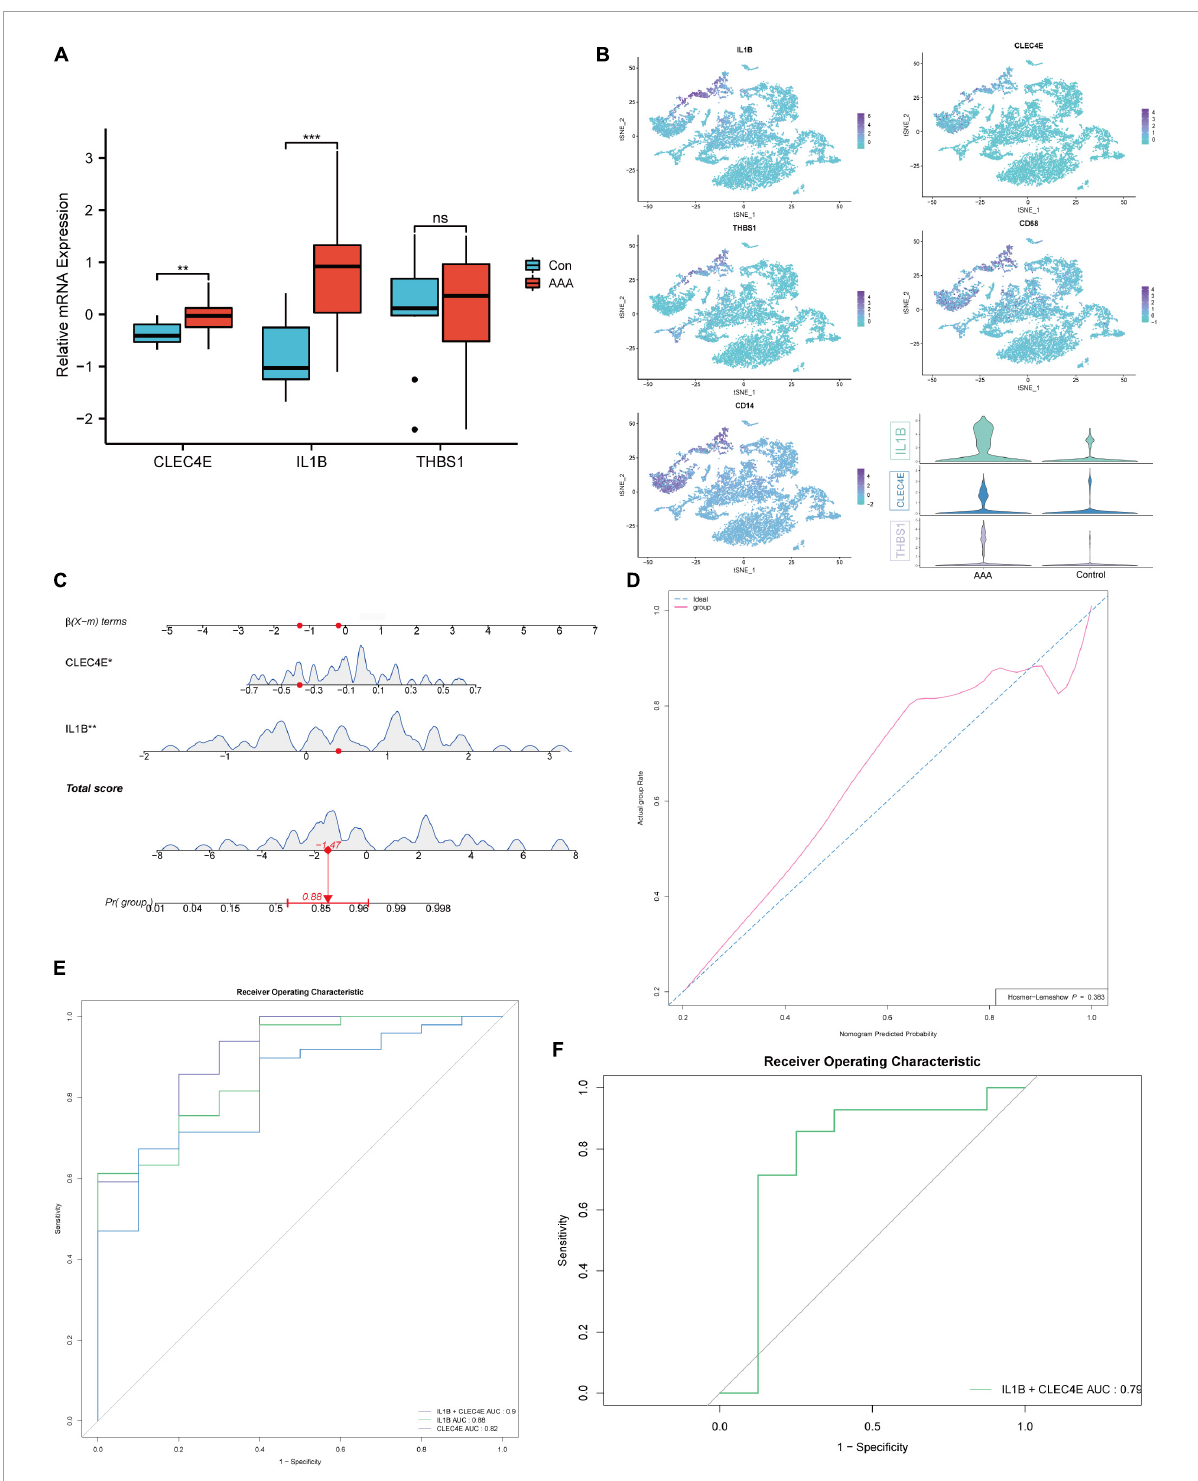
FIGURE5 Construction of the logistic regression diagnostic model. Boxplot showing the relative expression of CLEC4E , IL1B , and THBS1 in AAA and control aortas for human AAA dataset (GSE57691) (A) . CLEC4E , IL1B , THBS1, and CD68 expression in different cell types of human AAA scRNA-seq dataset (GSE166676) (B) . Dynamic nomogram of the two-gene-based model for predicting patients with AAA (C) . The calibration curve of the model (D) . ROC curves for the train dataset GSE57691 (E) and the validation dataset GSE47472 (human AAA neck) (F) . ** P < 0.01, *** P <